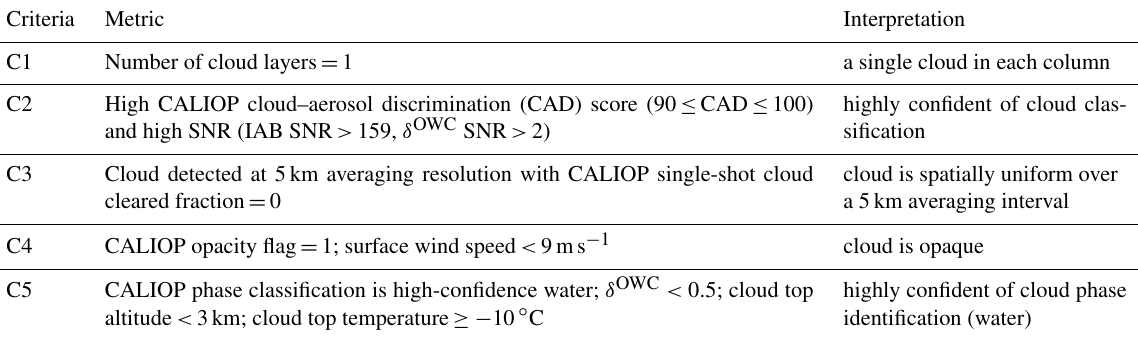
Table B2. Criteria used to select the opaque water clouds (OWCs) for the application of the DR method to obtain the AAC frequency of occurrence, AAC optical depth, AAC lidar ratio and DARE OWC in this